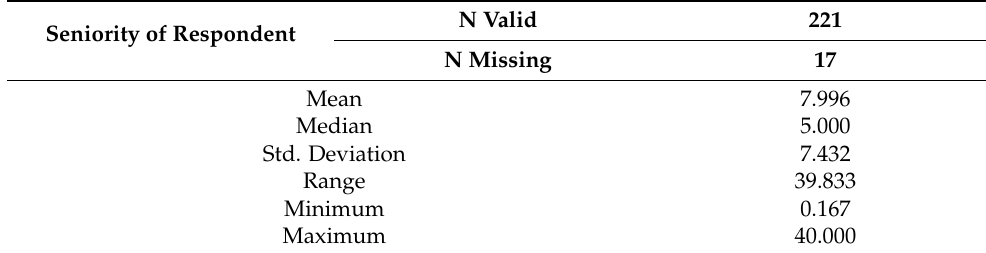
Table 3. Variability indicators of the respondents, according to seniority–years in job position (own elaboration,